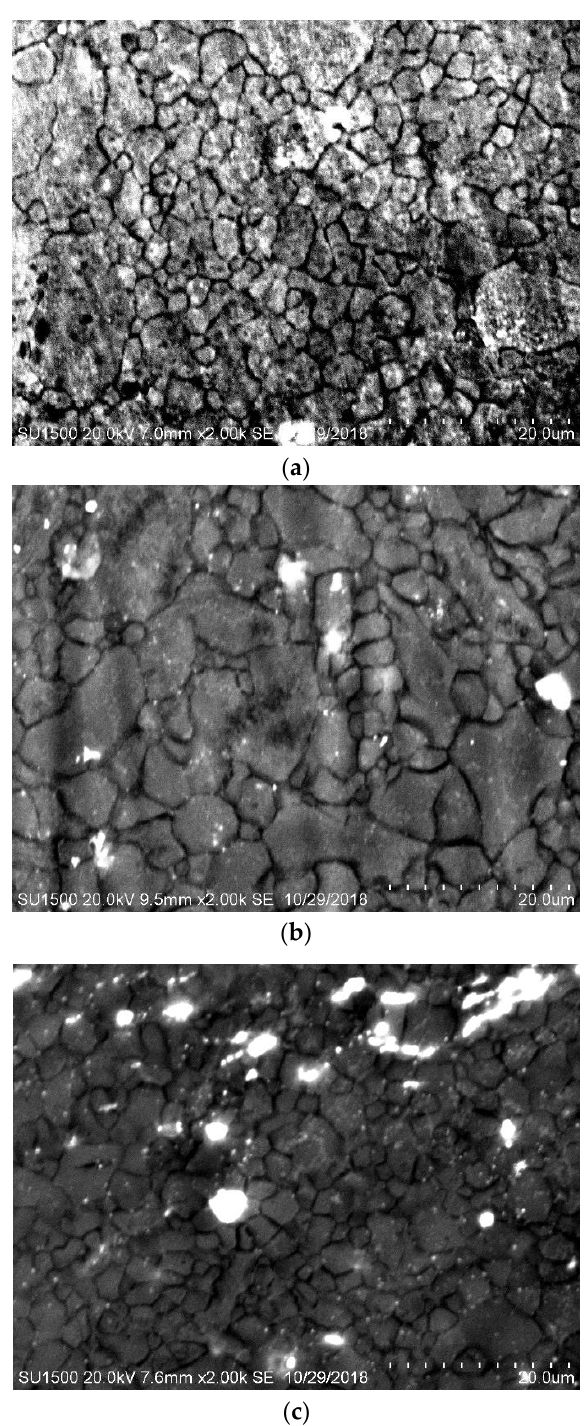
Figure 3. SEM microstructure of the extruded Mg alloys. ( a ) Extrude1, ( b ) Extrude2 and ( c ) Extrude3.